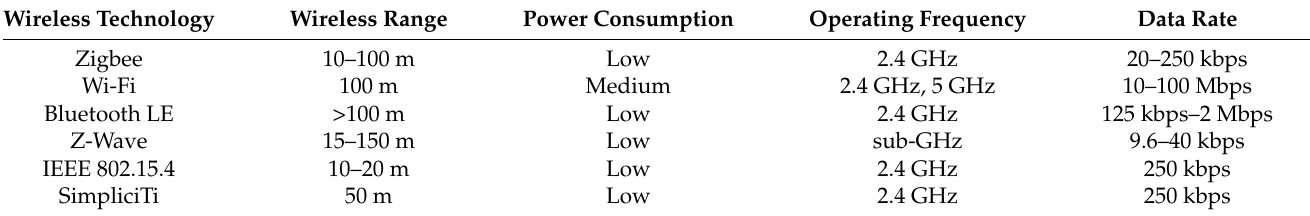
Figure 5. A typical WSN architecture for solid waste handling systems. Table 2. Comparison of popular WSN-enabled wireless